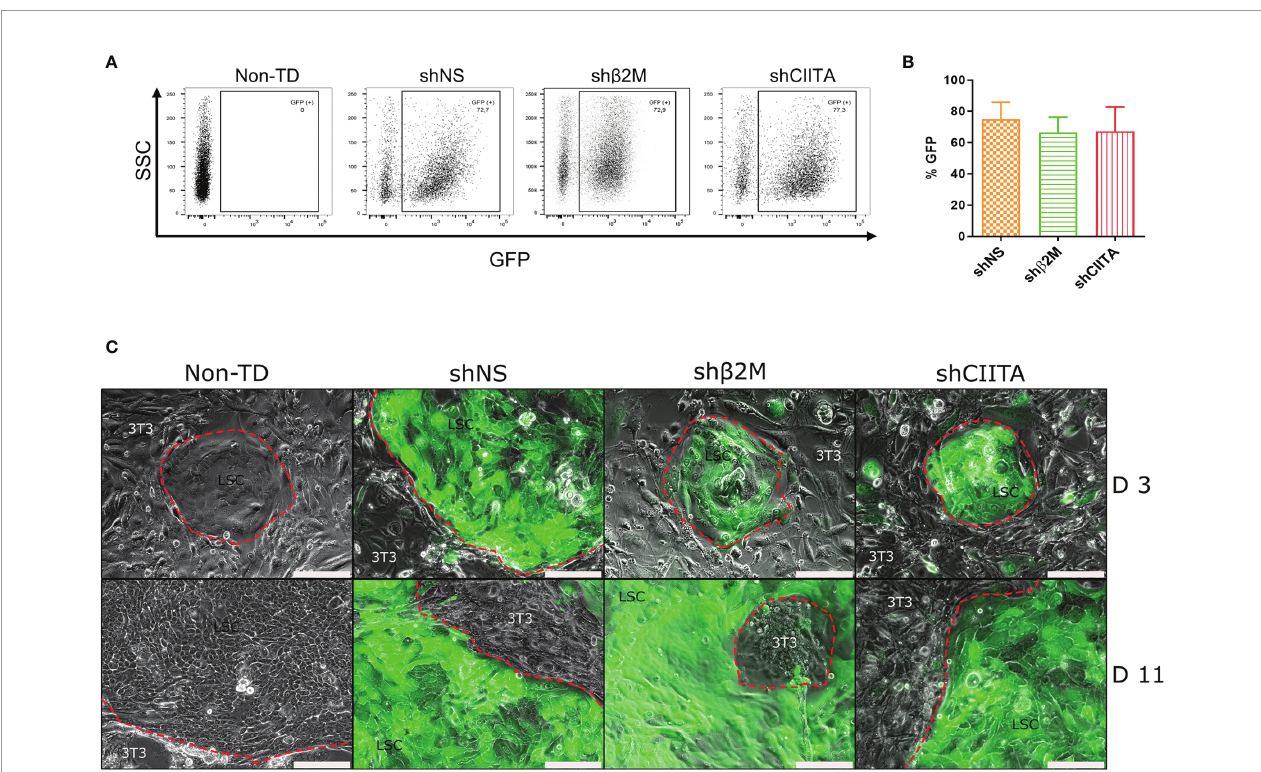
FIGURE 2 | Limbal stem cell morphology and growth dynamics are not compromised after lentviral transduction and silencing HLA expression. (A) GFP expression of transduced cells with shNS-, sh b 2M- or shCIITA-encoding vectors. (B) Mean GFP expression of transduced LSCs (n=6). Data are presented as mean ± SD. (C) Limbal stem cells (LSCs) cultivated onto lethally irradiated 3T3 feeder cells at day 3 (d3) and day 11 (d11) after transduction with shNS (vector control), sh b 2M (shRNA targeting b 2-microglobulin) and shCIITA (shRNA targeting class II major histocompatibility complex transactivator). LSCs form typical colonies with preserved small stemness-like-morphology. Scale bar: